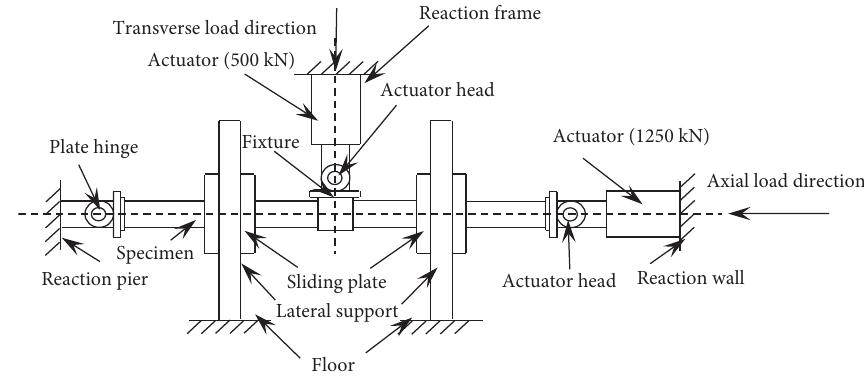
Figure 2: Loading diagram of C-CF-CFRP-ST specimens with compression bending hysteretic behavior.